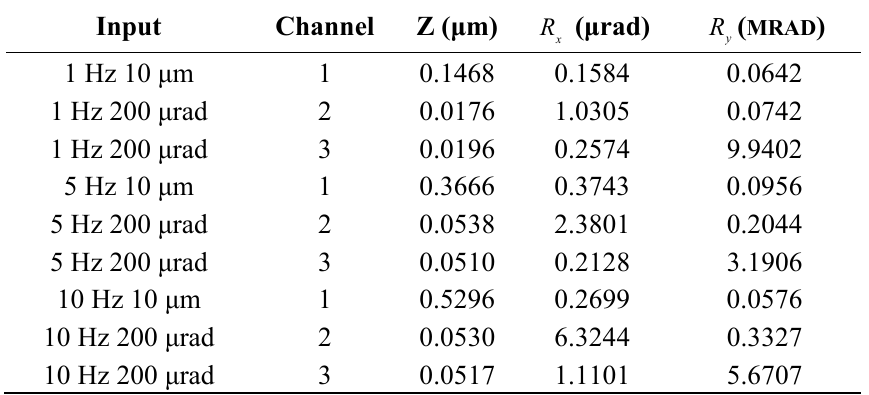
Table 7. Estimation error by applying the online estimation